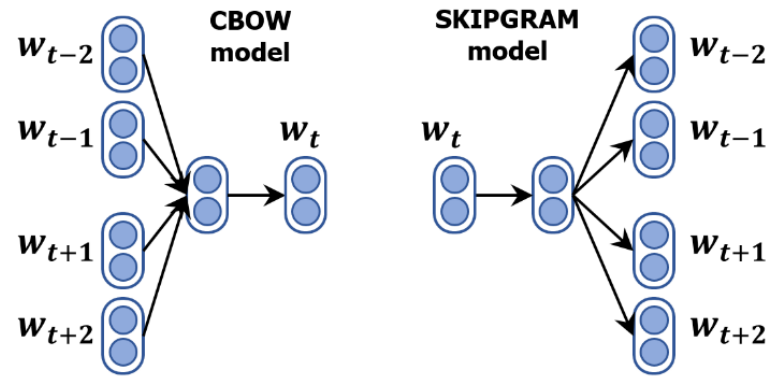
Figure 3. The architecture of the Word2Vec models: CBOW and skip